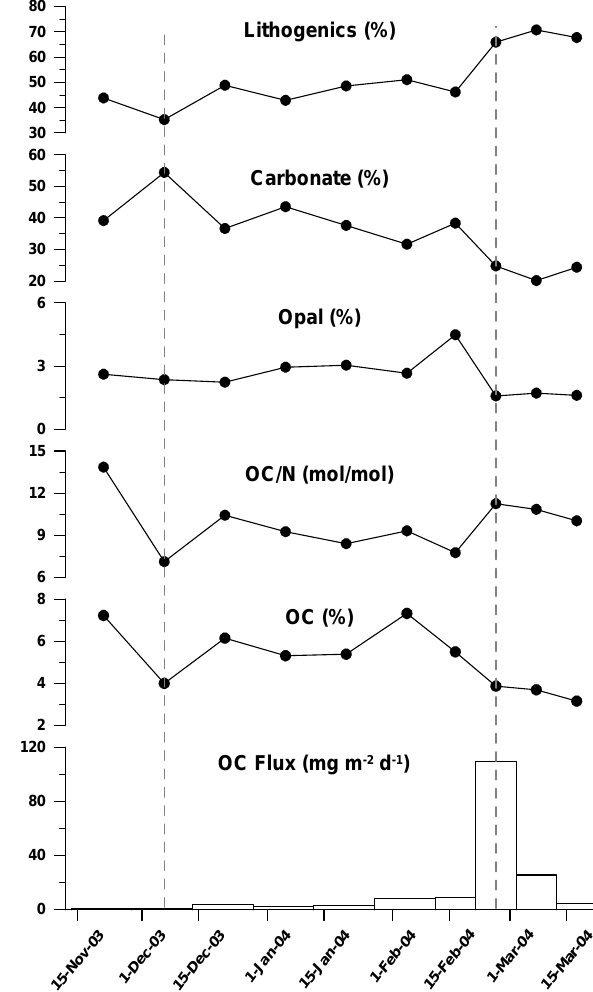
Fig. 3. Simultaneous time series of: near-bottom currents, near- bottom temperature and near-bottom turbidity from the inner shelf (SH) and the Cap de Creus (CC) submarine canyon; and near- bottom current speed, near-bottom temperature and downward total mass fluxes at the basin site (BS) during the deployment period. Grey bands represent the timing of major E-SE storms.